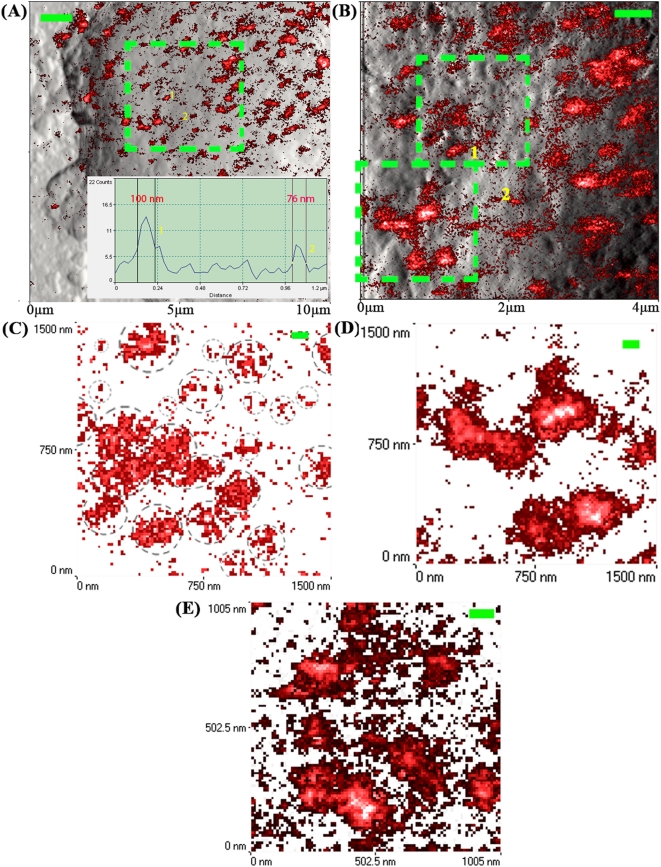
Direct NSOM visualization of the distribution of lipid raft markers at nearly-natural state under best fixation conditions.(A) The NSOM image of GM1 (merged from the NSOM fluorescence images in red and the corresponding topographic images in gray) was magnified from the boxed area on the cell in Fig. 4B (Inset: the fluorescence profile of the cross section across the center of the two nanoclusters indicated by numbers 1 and 2). (B) The NSOM image was magnified from the boxed area in Fig. A. (C, D) The NSOM images, corresponding to the upper (C) and lower (D) boxed areas in Fig. B, were merged from three (C) and four (D) repeatedly-scanned fluorescence images of the same areas to balance the blinking effect of fluorescent QD. (E) The NSOM image of CD59 (merged from three repeatedly-scanned fluorescence images of the same area) was magnified from the boxed area on the cell in the right image of Fig. 4E. Scan size: (A–E) 10×10 μm2; 4×4 μm2; 1.5×1.5 μm2; 1.5×1.5 μm2; ∼1.0×1.0 μm2. Scale bar/resolution: (A) 1 μm/500×500 pixel2; (B) 500 nm/400×400 pixel2; (C–E) 100 nm/100×100 pixel2; Integration time: (all) 30 ms.